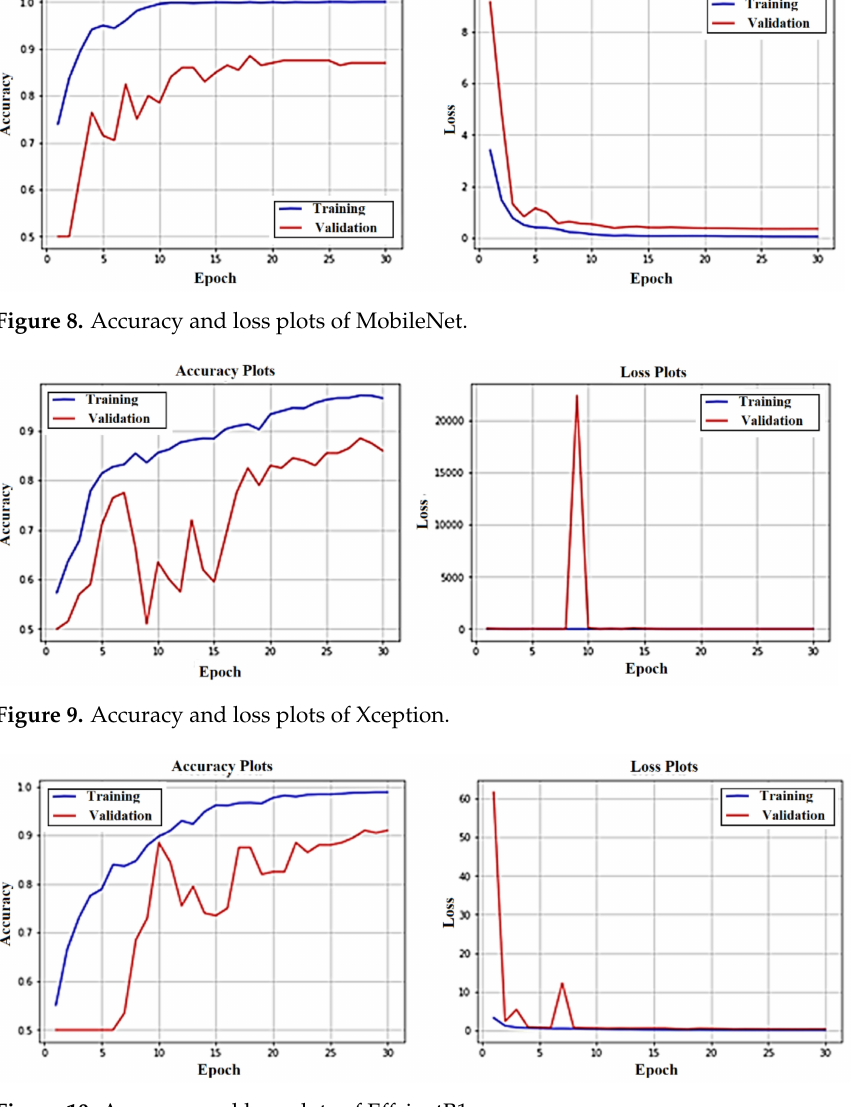
Figure 10. Accuracy and loss plots of